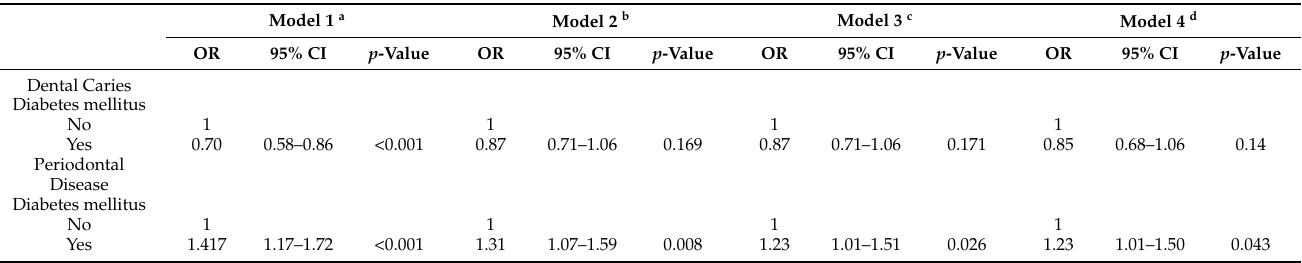
Table 4. Association between self-reported diabetes mellitus and tooth extraction due to dental caries and periodontal